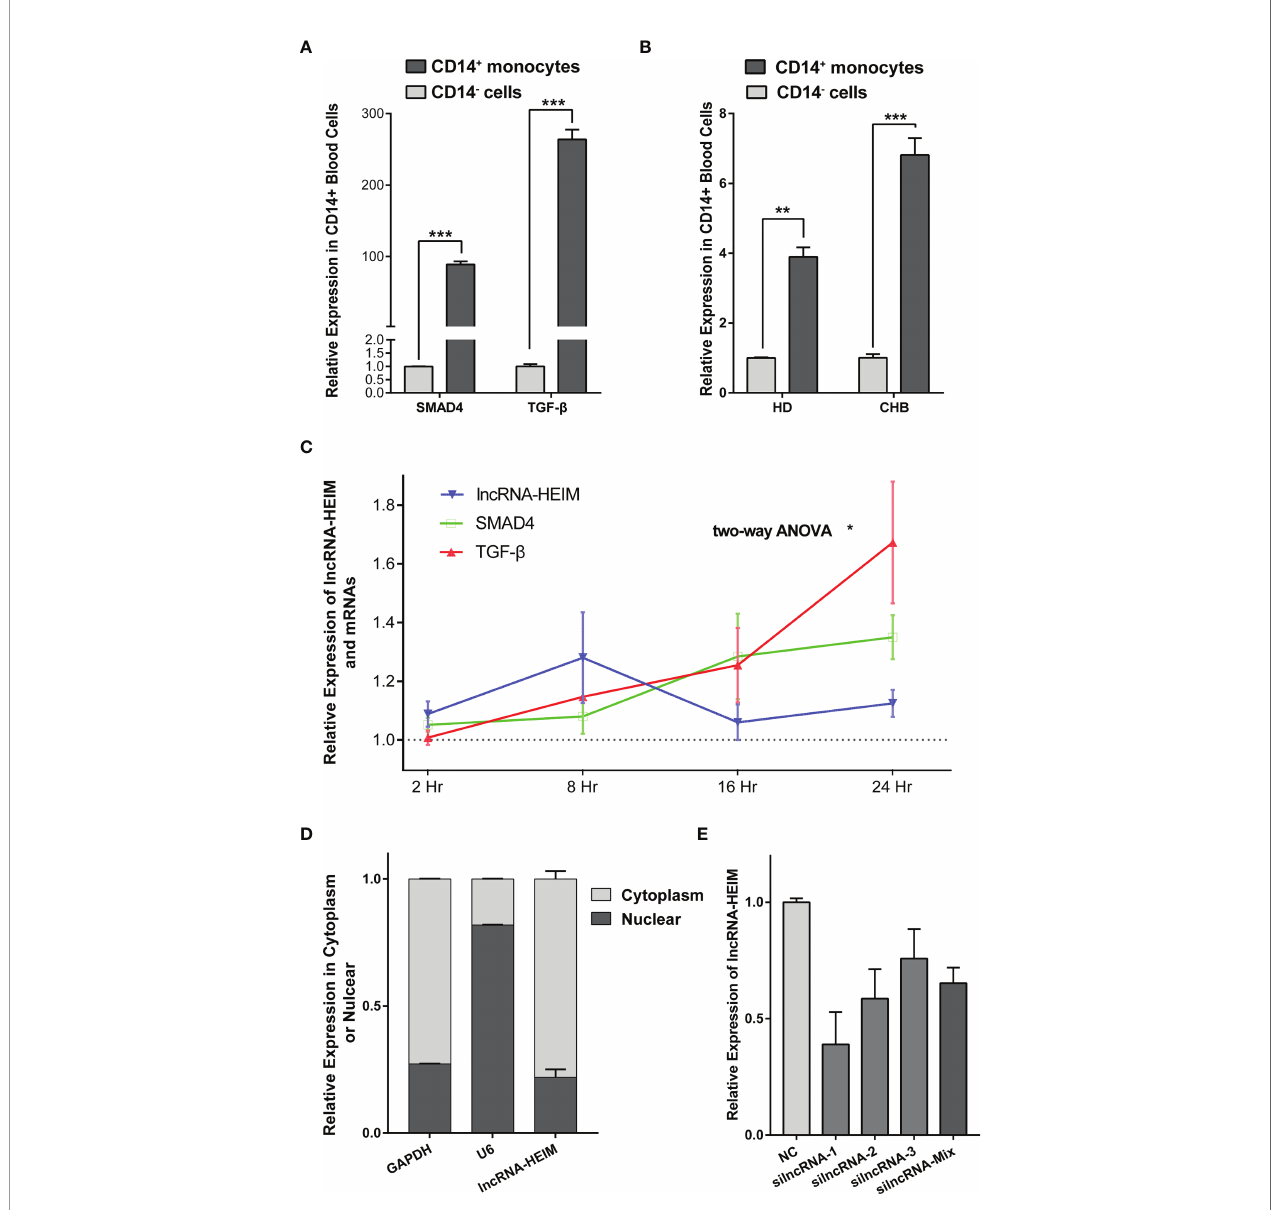
FIGURE 3 | lncRNA-HEIM ENST00000519726 was highly expressed in monocytes. (A) Relative expression levels of SMAD4 and TGF- b in CD14 + monocytes against those in CD14 − cells from CHB patients. (B) Relative expression levels of lncRNA ENST00000519726 in CD14 + monocytes against those in CD14 - cells from either healthy donor (HD) or CHB patients. (C) Relative expression levels of lncRNA-HEIM, SMAD4, and TGF- b in monocytes at 2, 8, 16, and 24 h upon HBV infection. Expression levels of lncRNA-HEIM, SMAD4, and TGF- b were normalized with negative control at each time point. Comparisons over groups were analyzed using two-way ANOVA followed by Tukey ’ s multiple comparisons test. ∗ p < 0.05. Blue line is for lncRNA-HEIM, while green and red lines are for SMAD4 and TGF- b , respectively. (D) Relative expression levels of lncRNA-HEIM, glyceraldehyde-3-phosphate dehydrogenase (GAPDH), and U6 in cytoplasm or nuclear of monocytes. GADPDH was used as cytoplasmic control transcripts, and U6 as nuclear control. (E) Relative expression levels of lncRNA-HEIM transfected with negative control or siRNAs targeting lncRNA-HEIM (silncRNAs). **p < 0.01, ***p <